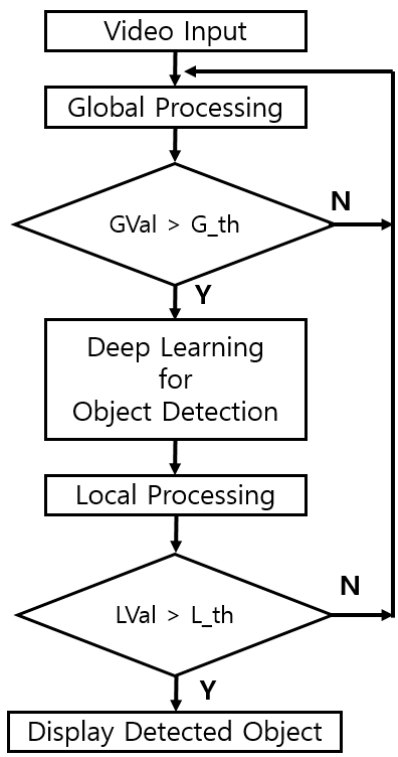
Figure 1. Flowchart of the proposed algorithm.